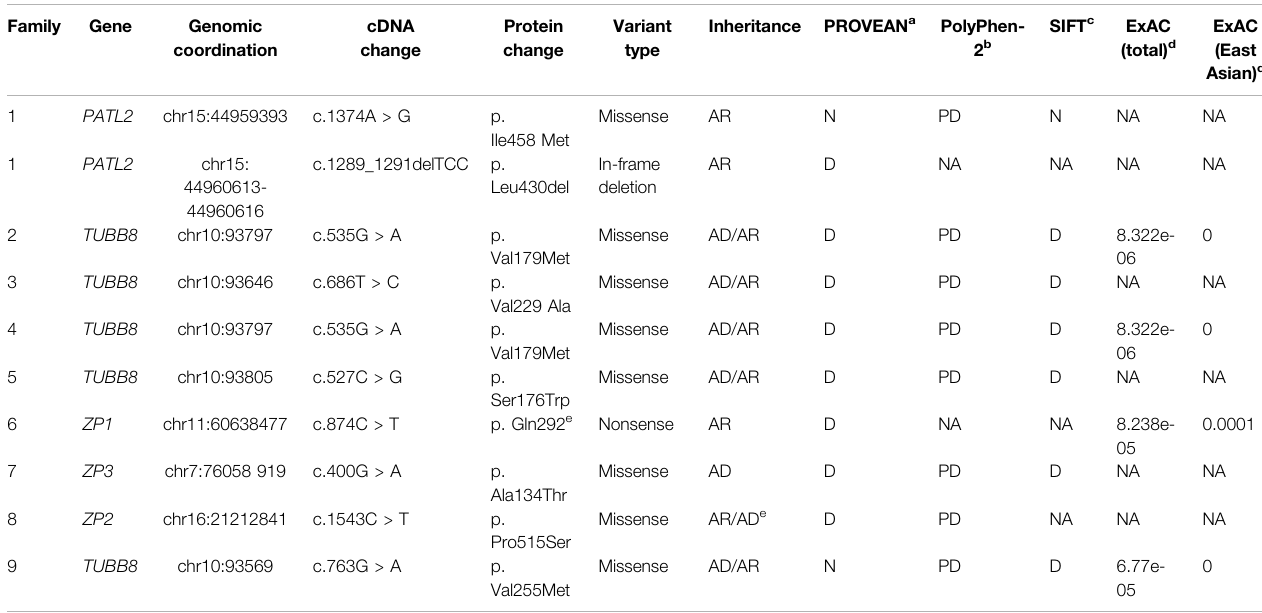
TABLE 3 | Overview of related mutations in the 9